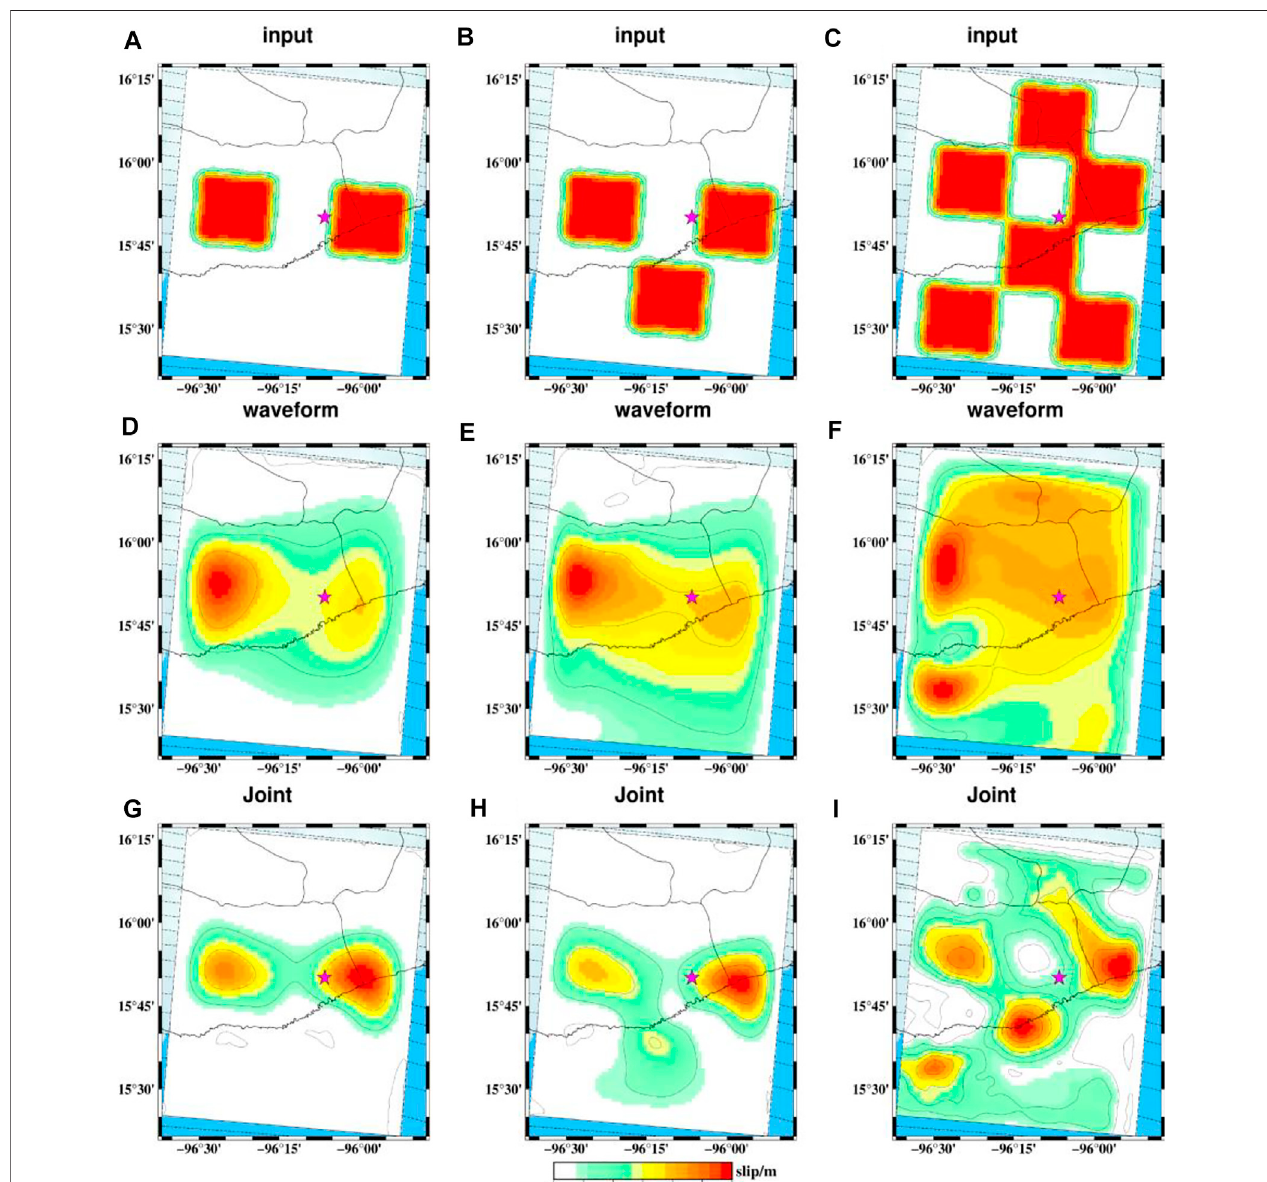
FIGURE12| Checkboardtestoftheinversionresolutionwithdifferentslippatchesanddifferentdatasetscombination. (A – C) denotetheinputmodelwesimulated. (D – F) denote the inversion results used waveform data. (G – I) denote the inversion results used joint data.